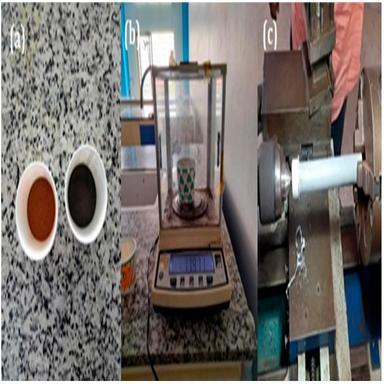
Fabrication of composite material (a) poured in cups (b) Weighing (c) machined to the required dimensions in a lathe.